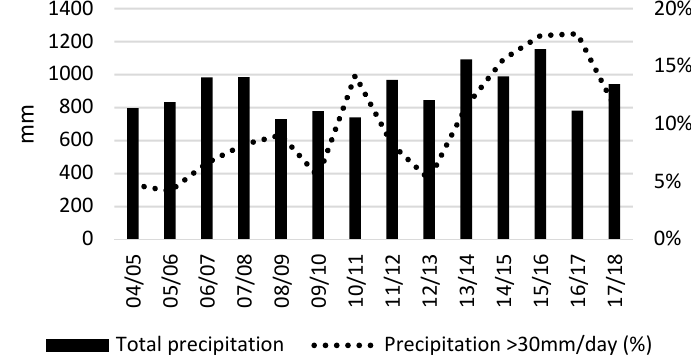
Figure 3. Annual precipitation during the monitoring period and precipitation intensities [18].